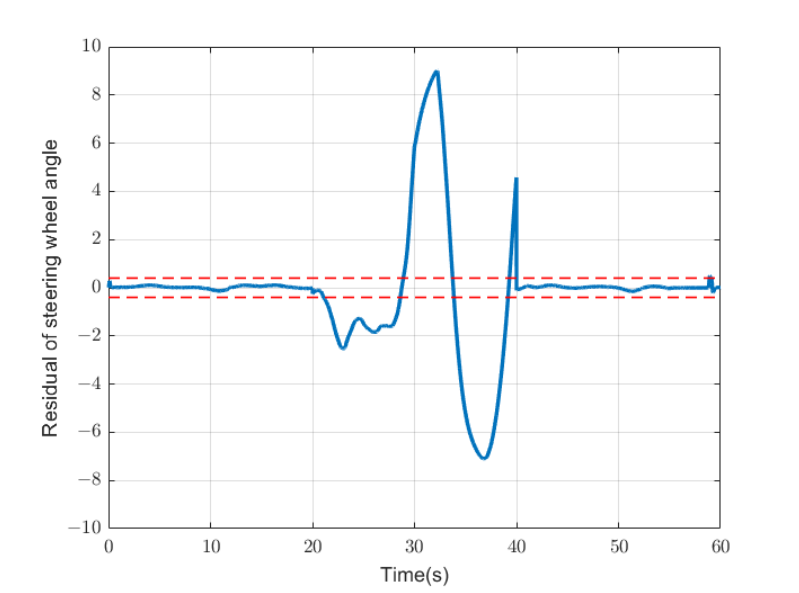
Figure 6. An example of the static threshold: the blue line represents the residual value of the steering-wheel angle, and the red dotted line represents the static threshold. Between 20 and 40 s, the blue residual value obviously exceeds the static threshold and is considered abnormal.